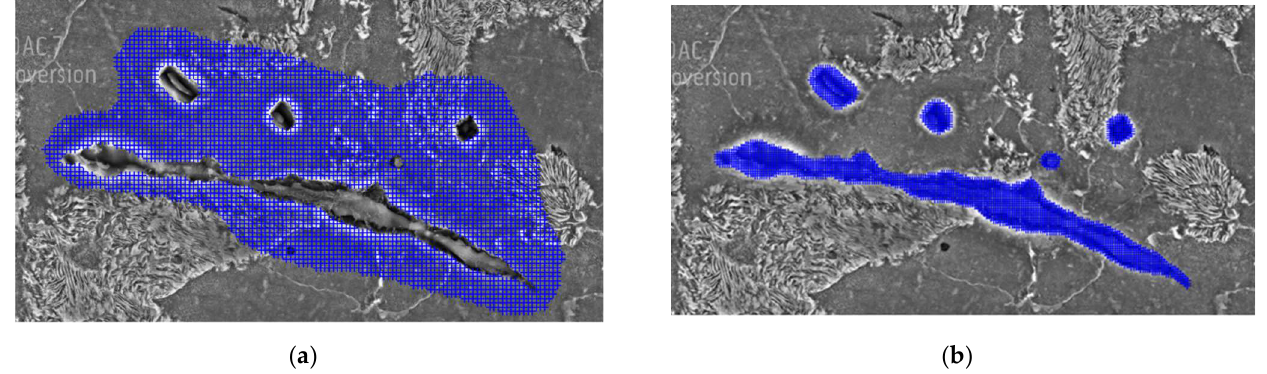
Figure 6. Calculation network for digital image correlation ( a ) around non-metallic inclusions ( b ) in non-metallic inclusions and cavity area. In this work, a grid of 9 × 9 pixels (coarse) for the matrix and 5 × 5 pixels for the inclusion (fine) was chosen to get accurate and fully resolved results.